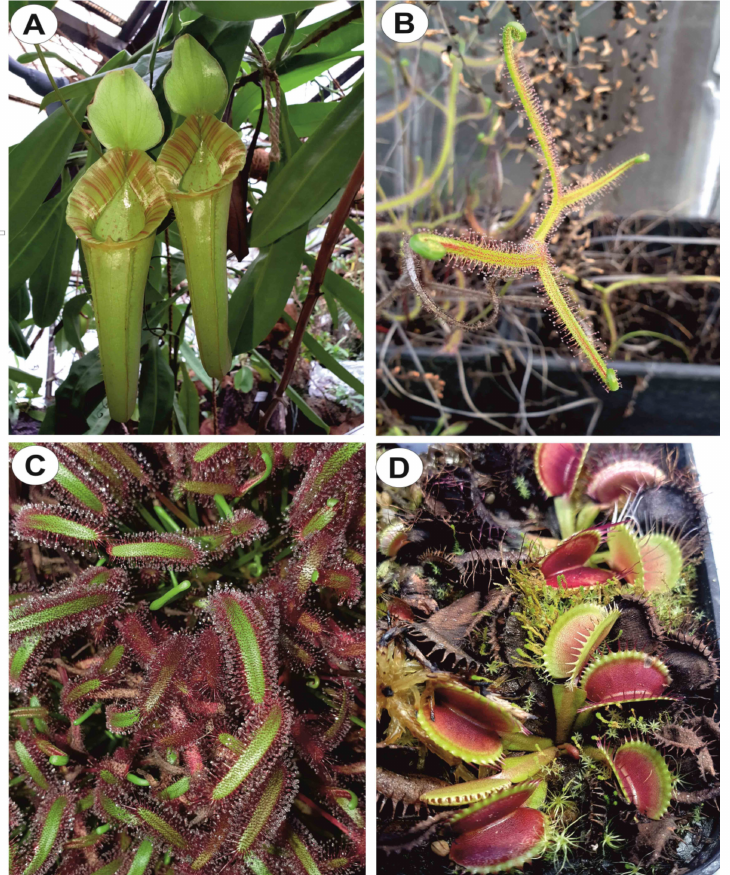
Figure 1. Examples of plants from Nepenthaceae and Droseraceae. ( A ) Nepenthes cv. ‘Miranda’, ( B ) Drosera binata Labill. var. dichotoma , ( C ) Drosera capensis L., ( D ) Dionaea muscipula